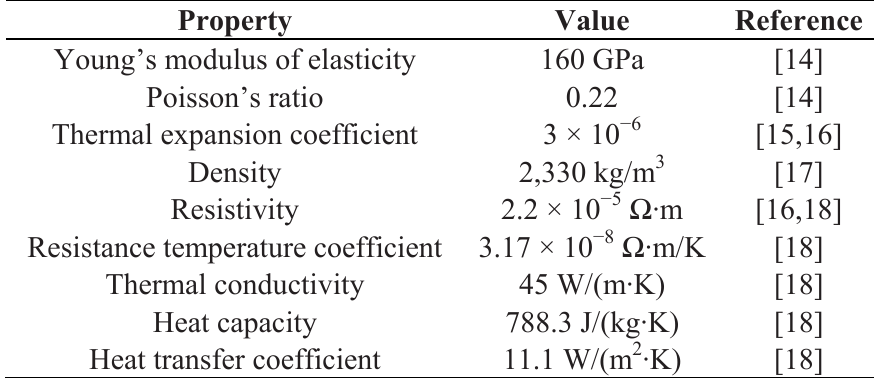
Table 1. Material properties used in running the COMSOL simulations.